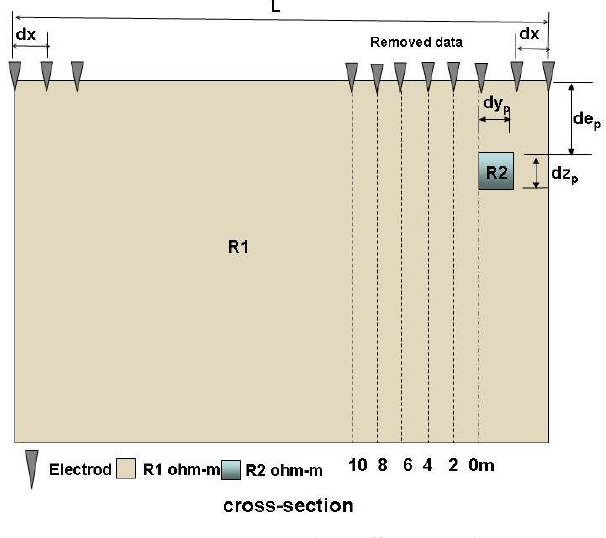
Figure 3. 2D boundary effect model.